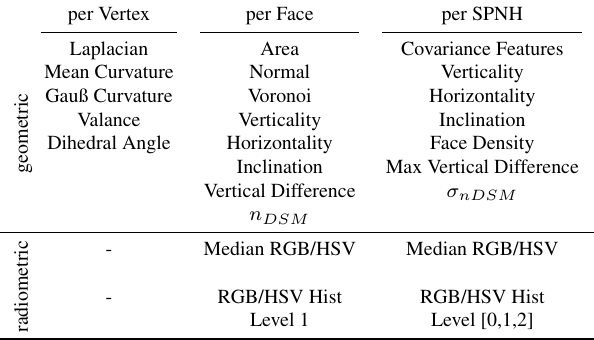
Table 1. Calculated features for each face. SPNH-based features are computed for SPNHs of radii 0 . 5 m , 1 . 0 m , 1 . 5 m . Histogram levels 0, 1, and 2 use 9, 20 and 64 bins respectively to map color values originally discretized in 256